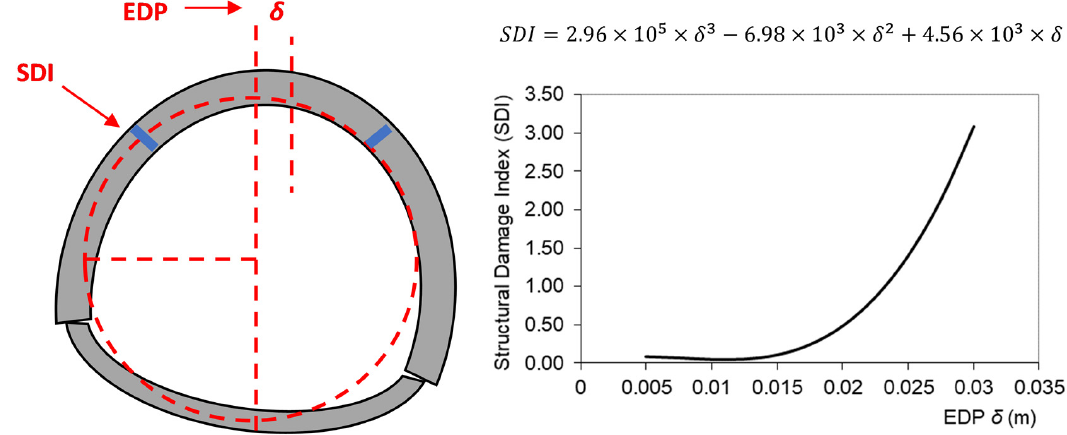
Figure 3. Definition of Damage Index ( DI ) and EDP for mountain tunnels and correlation between these metrics, following Andreotti and Lai